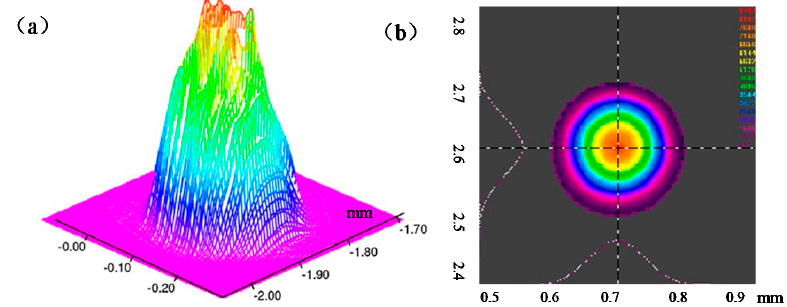
Figure 2. ( a ) Three-dimensional intensity distribution of the Gaussian beam; ( b ) Field distribution of the Gaussian beam in the focal plane.